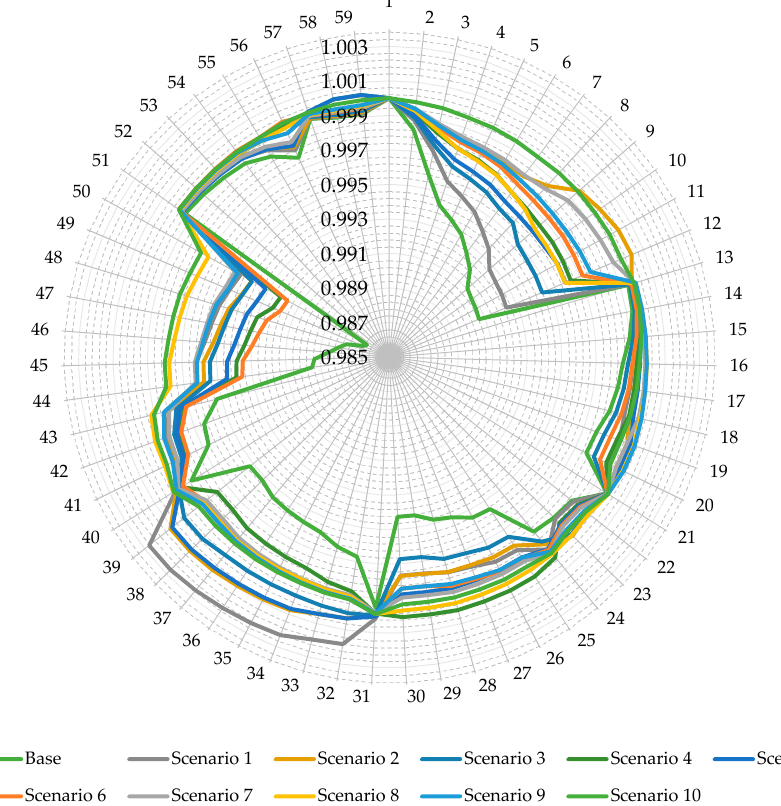
Figure 10. Voltage profiles for the 59-node system in different scenarios.